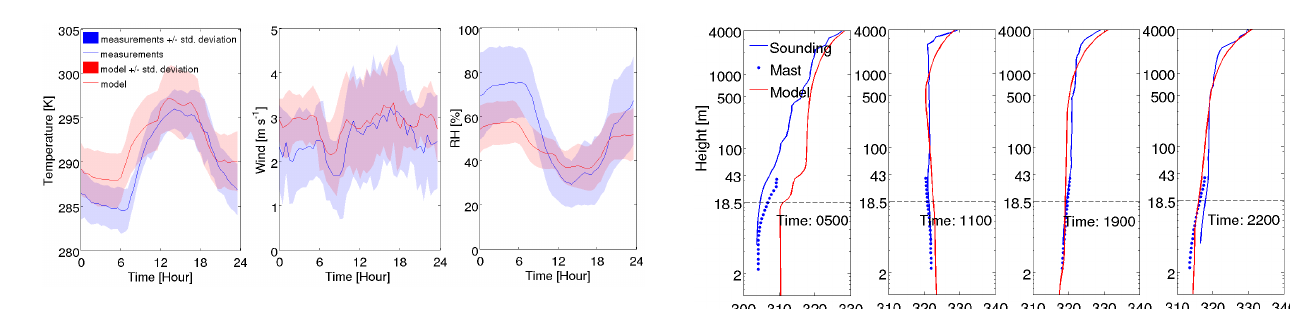
Figure 1. Averaged modeled and measured diurnal cycles of tem- perature (left), wind speed (middle), and relative humidity (RH, right). Measurement average (line) and ± 1 standard deviation (shaded area) are in blue; model average (line) and ± 1 standard deviation are in red. The comparisons are made above canopy at 30m.